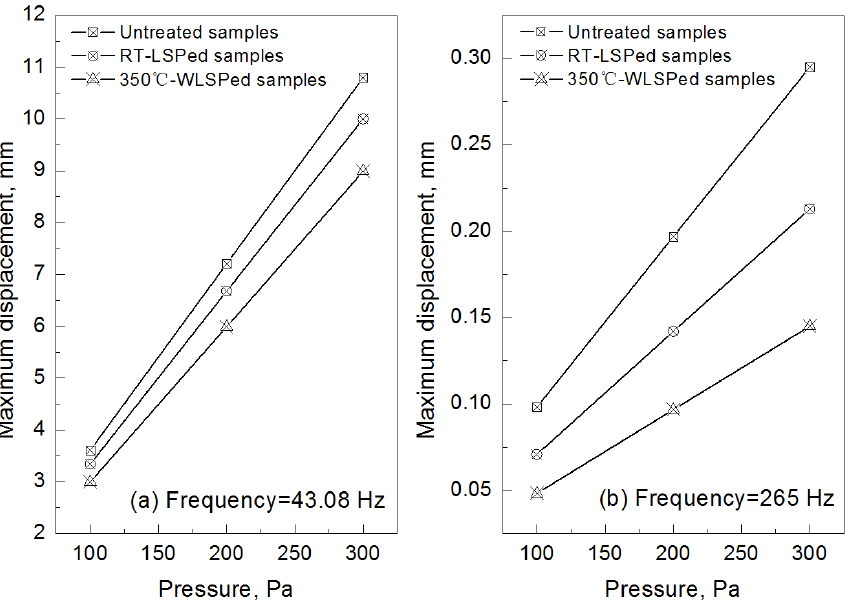
Figure 10. Vibration displacement as a function of loaded pressure. ( a ) Frequency = 43.08 Hz, ( b ) Frequency = 265 Hz.